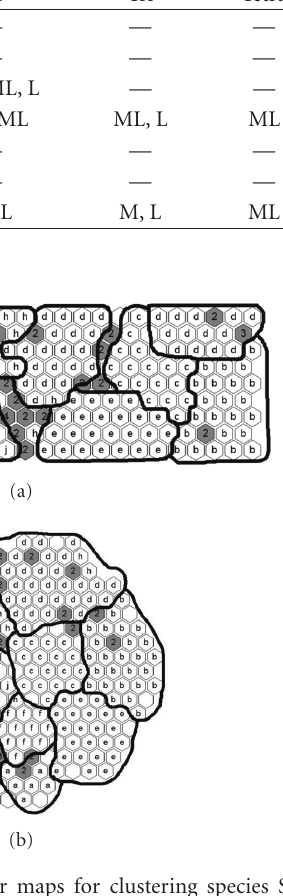
Figure 5: The labelled cluster maps for clustering species Set 1 by (a) SOM, (b) GSOM with the pentanucleotide frequency. Each hexagon represents a single node. If a node contains input samples from only a single species, it is displayed with a letter that uniquely identifies the species. Grey colour nodes correspond to two or more species in the node and the number of species is displayed on the node. A node without label means that there is no input sample